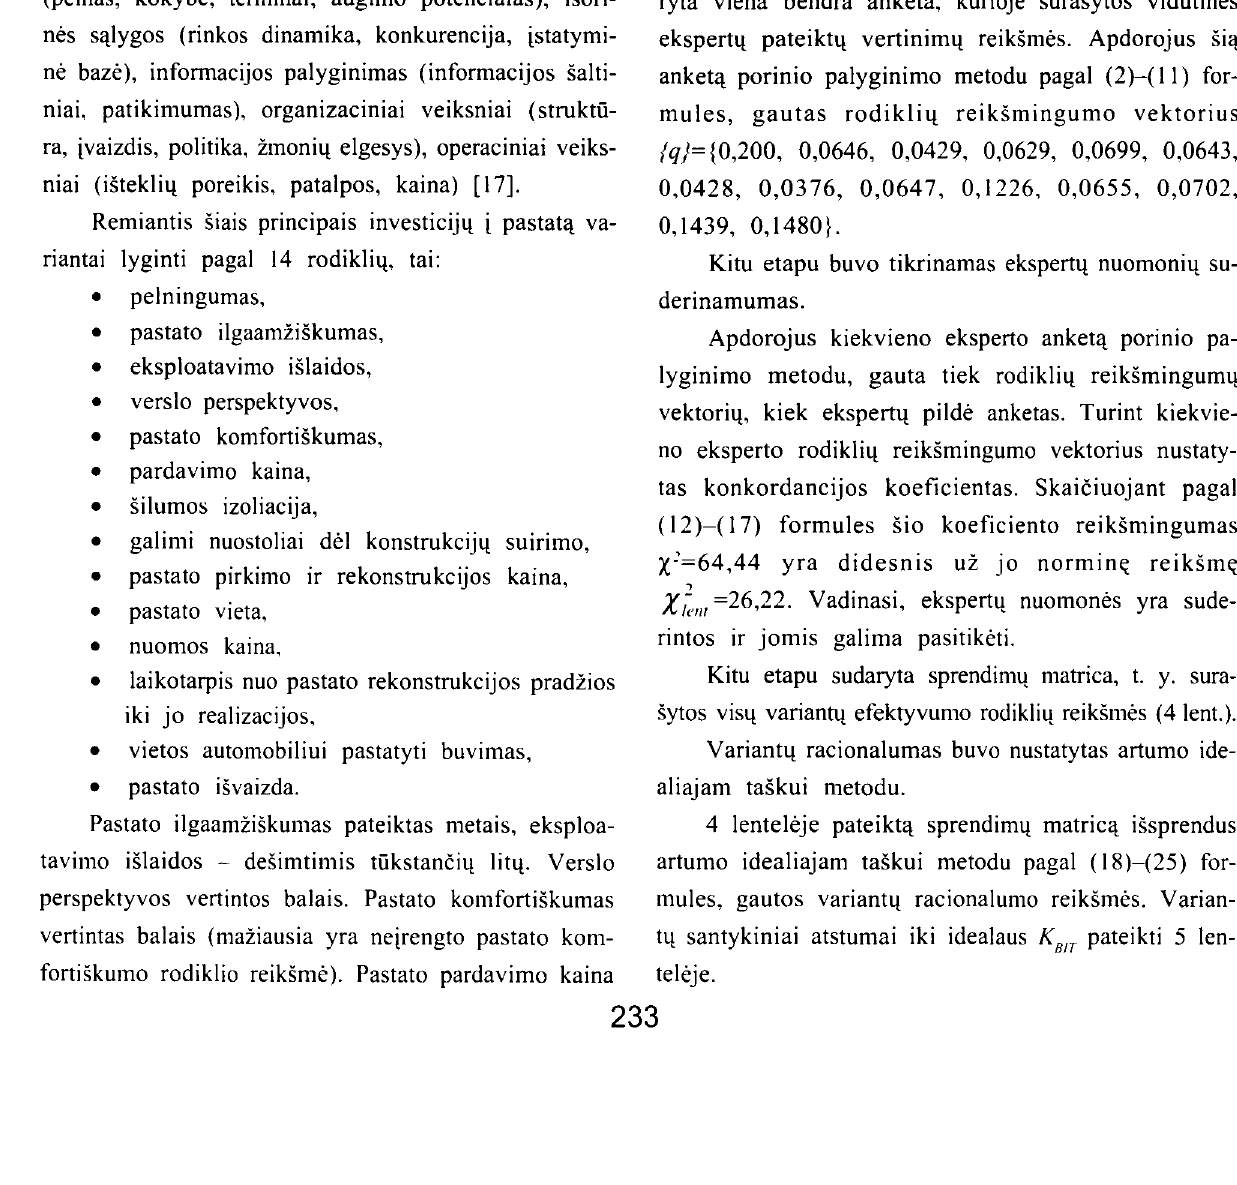
Fig 4. Schedule of reconstruction work without interior